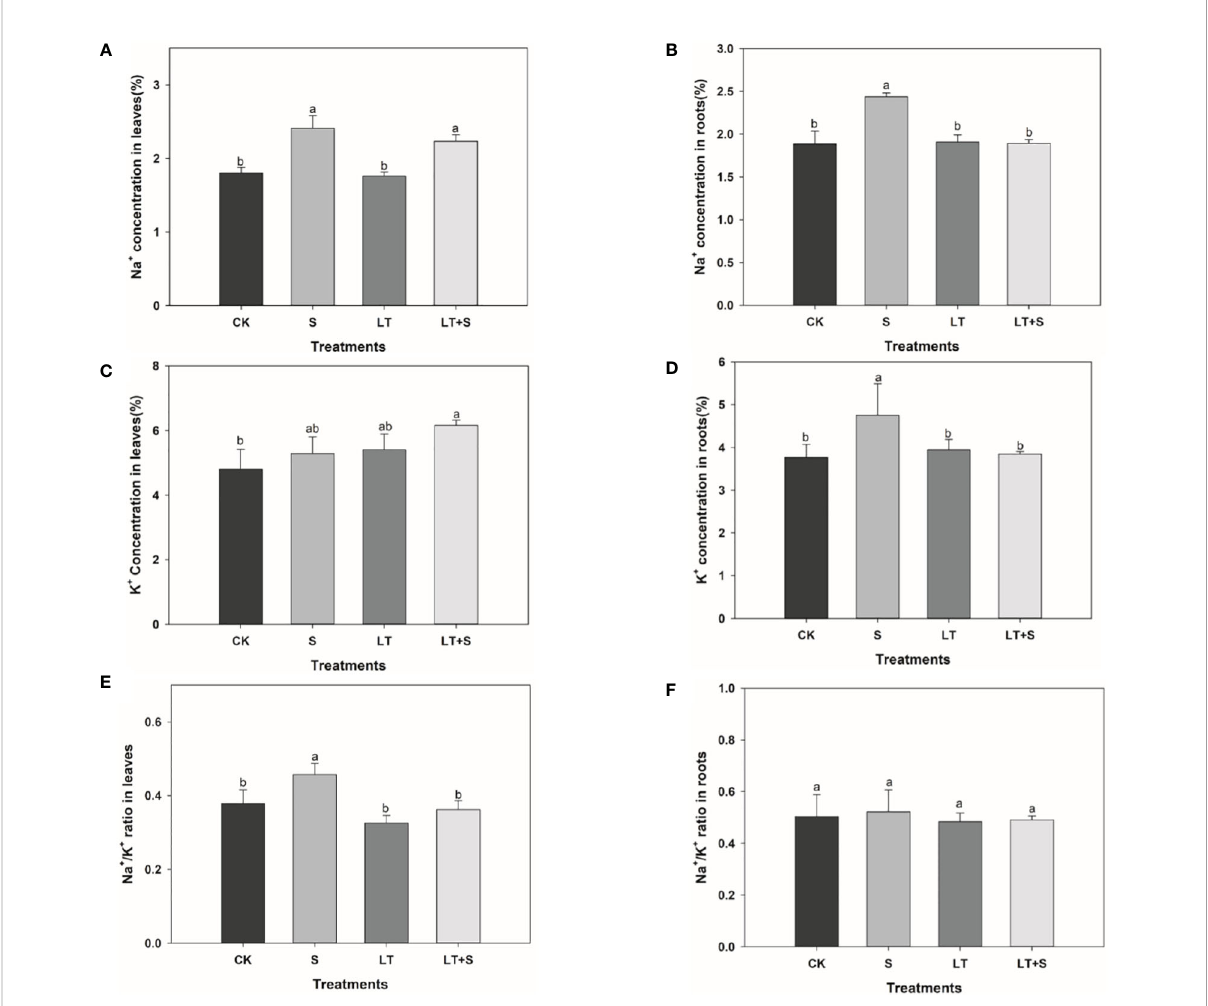
(Duncan ’ s multiple range